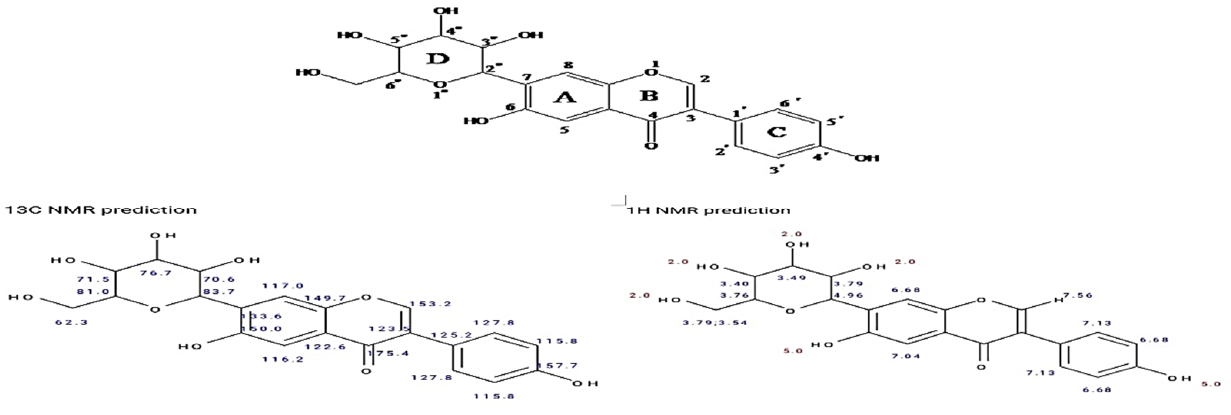
Figure 12. Structure of purified bioactive compound isolated from Leucas indica flowers. The letters A, B, C, and D were indicated to number the position of carbon